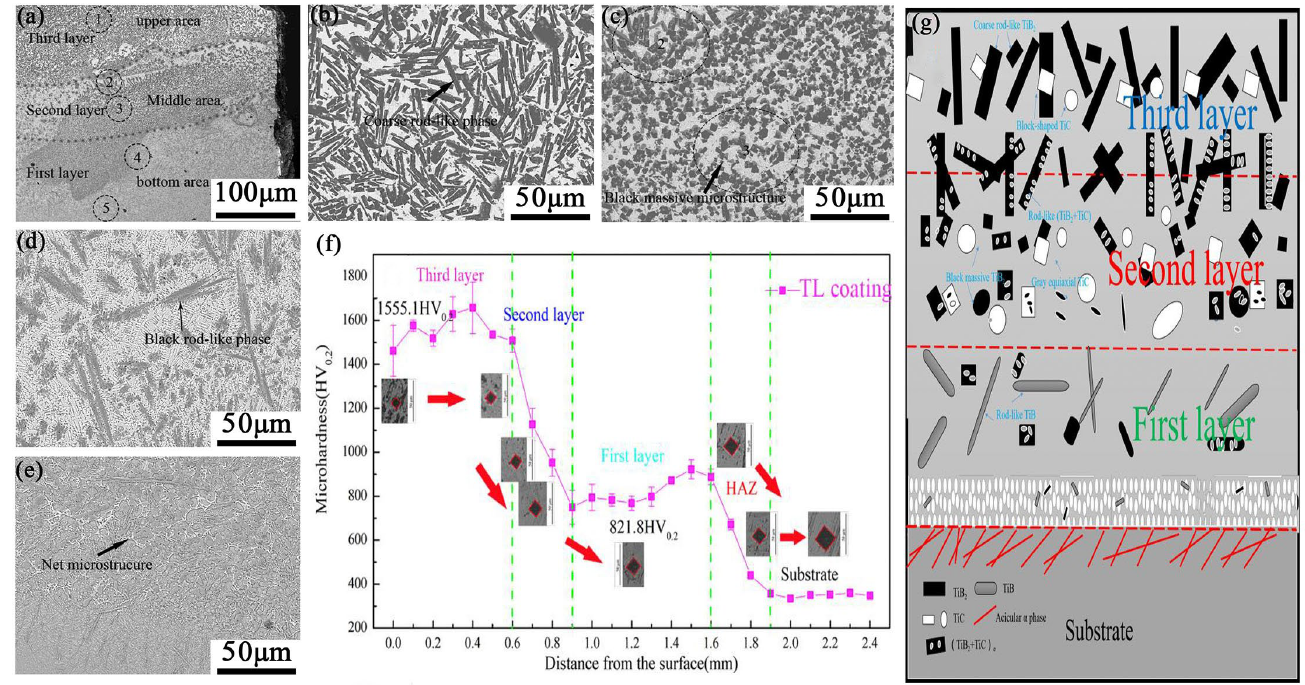
Figure 14. Microstructure, microhardness, and schematic diagrams of TiNi/Ti 2 Ni-based composite coatings with gradient distribution of TiC- and TiBx-reinforced phases on the TC4 alloy. ( a ) Overall microstructure along the cross-sectional direction, ( b ) enlarged microstructure of area 1 in ( a ), ( c ) enlarged microstructure of area 2 and 3 in ( a ), ( d ) enlarged microstructure of area 4 in ( a ), ( e ) en- larged microstructure of area 5 in ( a ), ( f ) microhardness variation along the cross-sectional direction, and ( g ) schematic diagram showing the reinforced phases distribution (the red line indicates the demarcation line of each coating) (reprinted from Ref. [241] with the kind permission of Elsevier). Actually, the service condition for a Ti-based alloy component is always